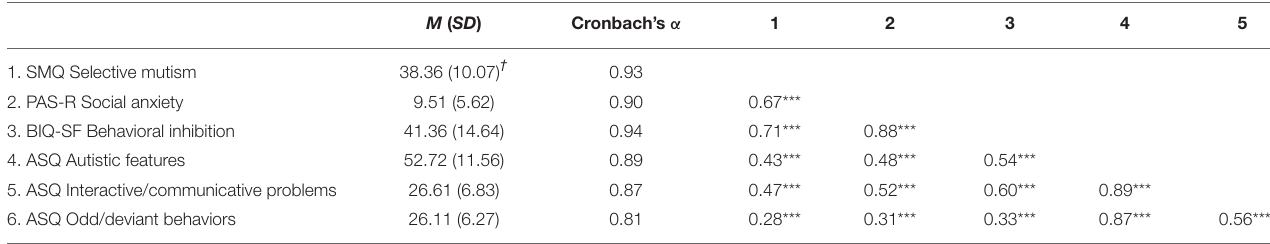
TABLE 1 | Mean scores (standard deviations) and reliability coefficients for parent-report questionnaires of children’s symptoms and temperament features as well as Pearson correlations among these measures. M ( SD